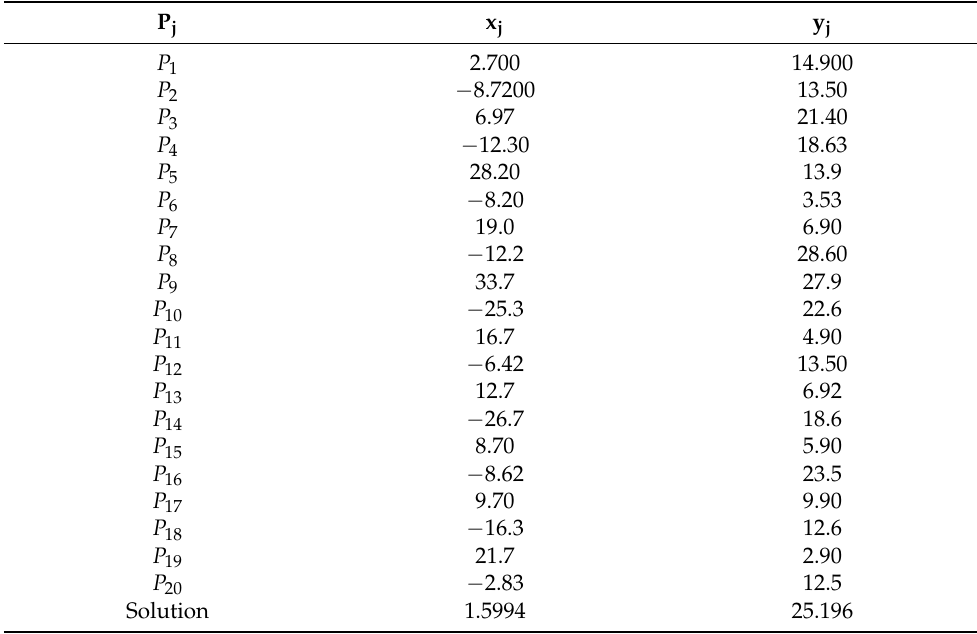
Table 2. F 1 = (6.00,6.00) and F 2 = ( − 8.00,8.00) are given with the equal weighted 20 points (Value is 1). The minimax value is 13.117.